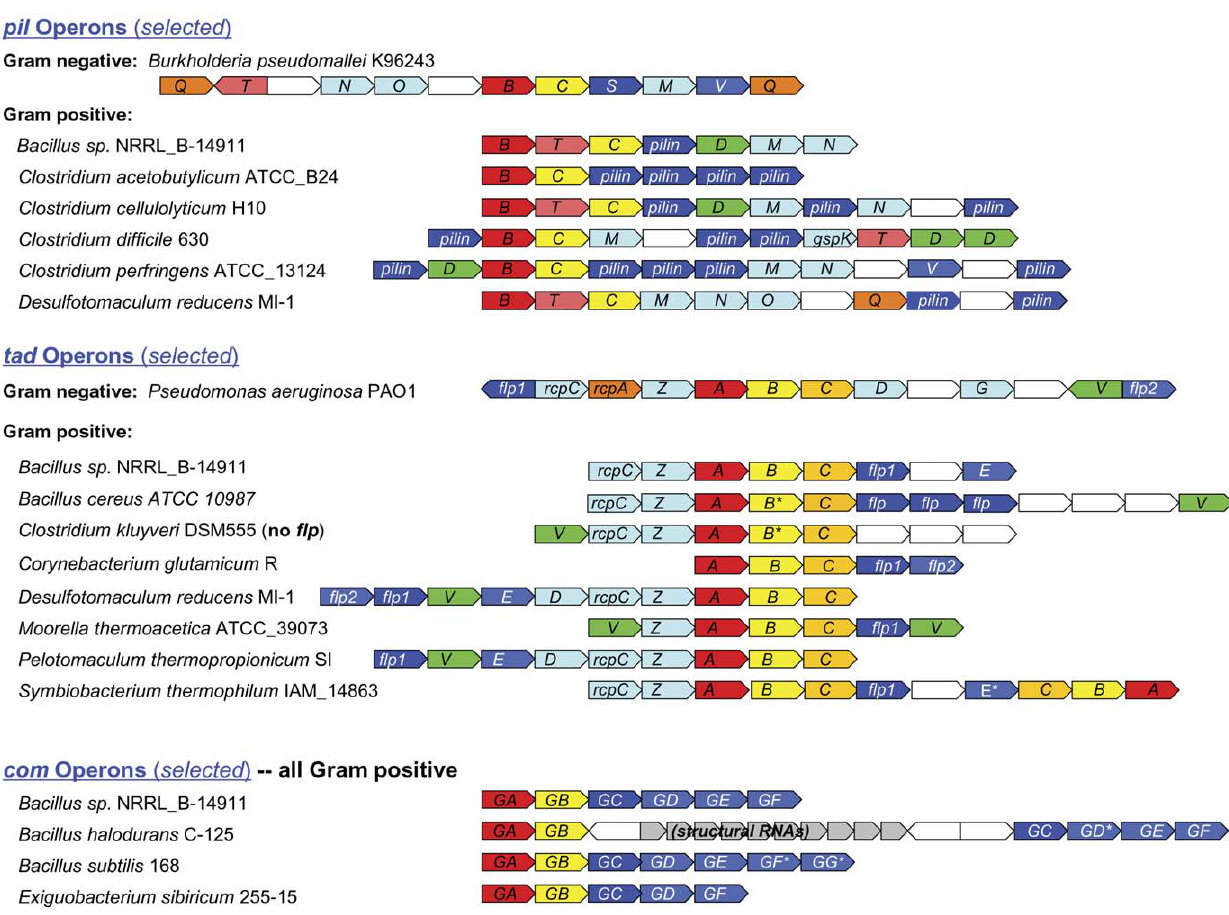
Figure 1. Physical maps of TFP loci in Gram-positive bacteria, compared with representative Gram-negative pil/tad loci. Arrows represent relative orientation of open reading frames (ORFs); genes are annotated based on high confidence BLASTP or Pfam hits against experimentally verified homologs. ORFs of the same color correspond to genes with similar function; white and gray arrows represent undefined ORFs. The Burkholderia pseudomallei pil and P. aeruginosa tad operons were selected as Gram-negative representatives based on their organizational complexity and experimentally verified components. A= tadA ; B= tadB ( tad operons) or pilB ( pil operons); C= tadC ( tad operons) or pilC ( pil operons); D= tadD ( tad operons) or pilD ( pil operons); E, G, Z= tadE , tadG and tadZ , respectively; M, N, O, Q, S, T= pilM , pilN , pilO , pilQ , pilS and pilT , respectively; V= tadV (tad operons) or pilV ( pil operons); GA, GB, GC, GD, GE, GF and GG= comGA , comGB , comGC , comGD , comGE , comGF and comGG , respectively. * indicates the absence of a prepilin peptidase cleavage site.